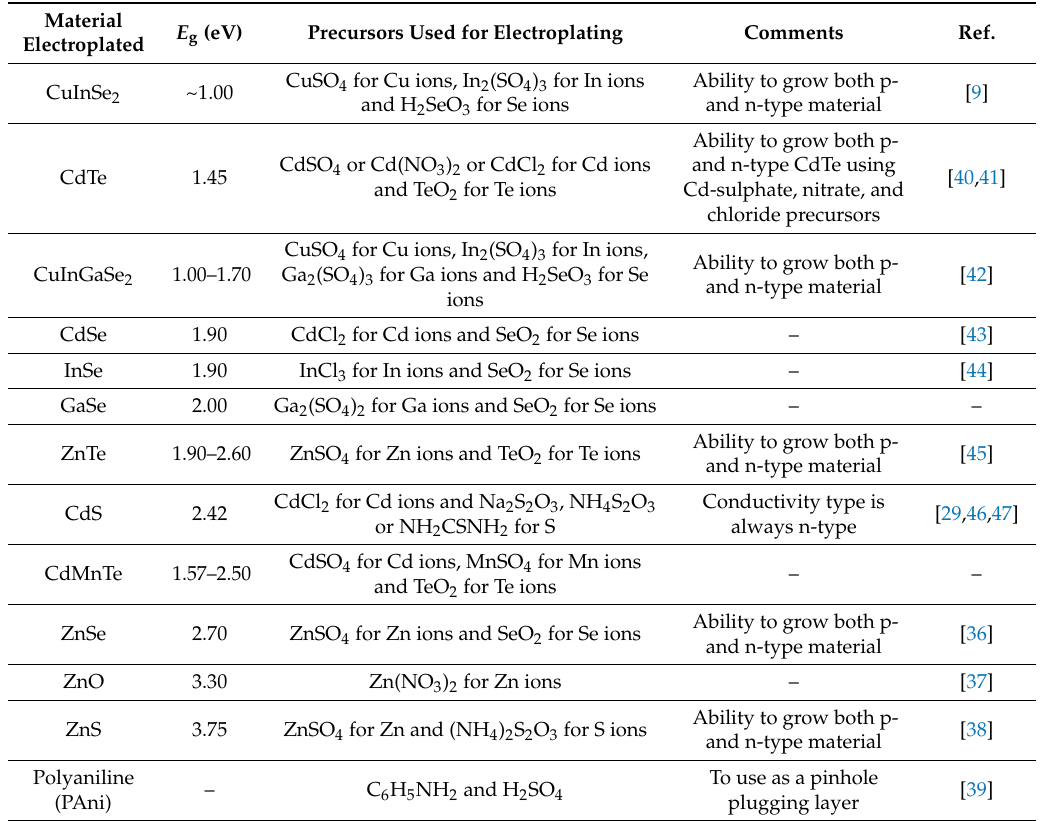
Table 1. Summary of explored electronic materials to date at authors’ research group using electroplating from aqueous